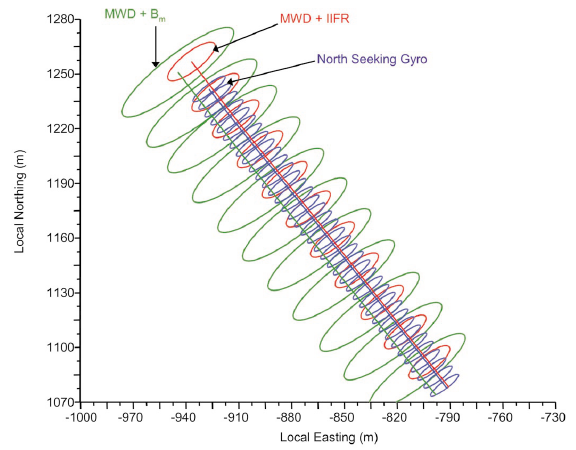
Fig. 4. Three sets of error ellipses on a section of wellpath demon- strating the size of errors associated with two directional survey correction methods for magnetic MWD surveys and a gyroscopic survey. Those associated with MWD and main field ( B m ) correc- tions only are shown in green, those for MWD with IIFR in red, and those derived for a north-seeking gyroscope are shown in blue. The data are from a 4-day period in 2001.